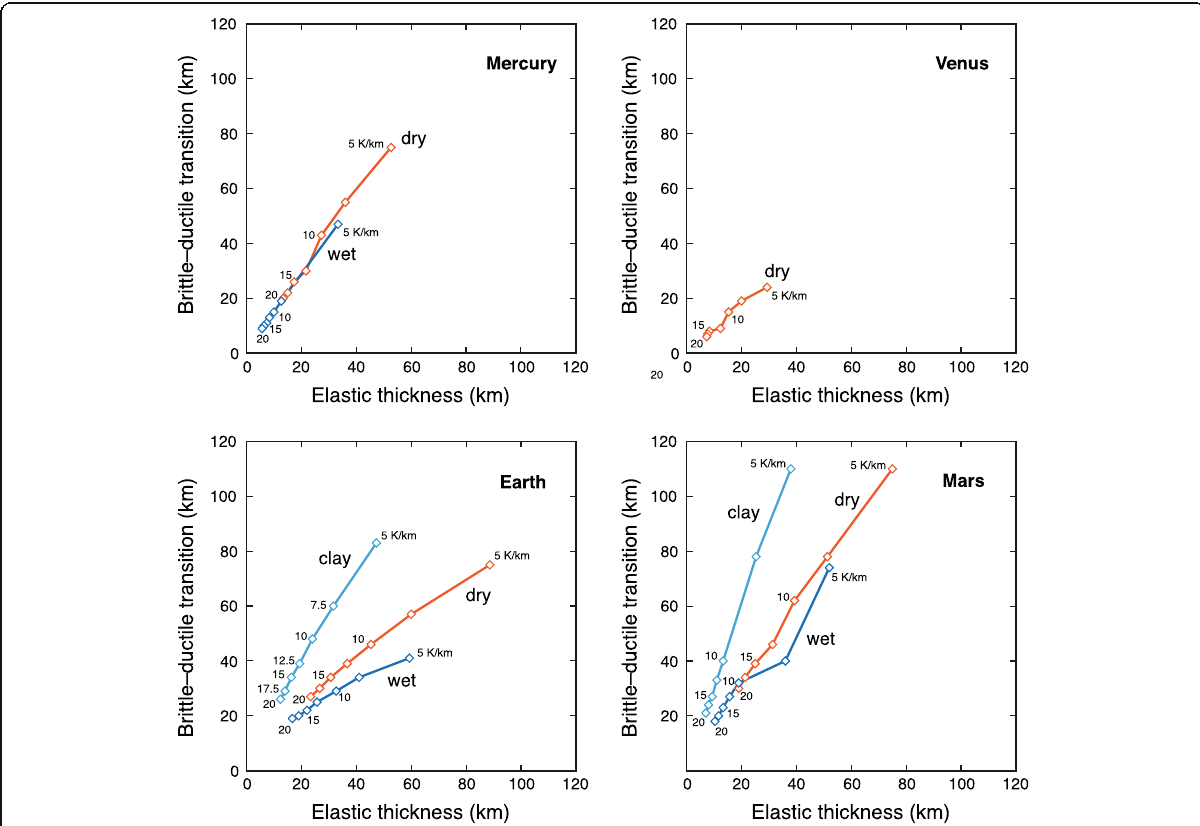
Fig. 10 Relationship between elastic thickness and depth of the brittle – ductile transition in each planet for various models. Calculations were performed using a constant strain rate of 10 − 17 s − 1 , and the other parameters are the same as those in Figs. 8 and 9. The values of thermal gradient for the calculations are labeled for each model. The relationship differs among planets and for the presence/absence of water and clay